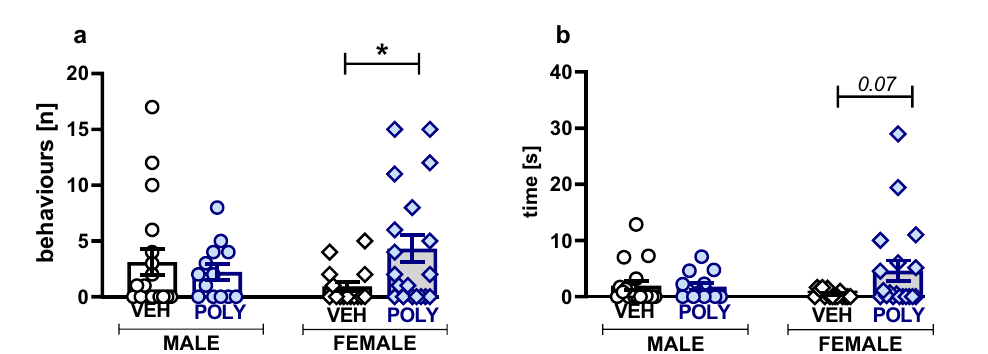
Figure 2. Aggressive behavior in the social interaction test. Poly(I:C) exposure increased the number and duration of aggressive episodes only in female rats. Data are presented as a mean ± SEM of the number of episodes ( a ) and time ( b ) of aggressive behavior. Symbols: *p < 0.05, a significant difference between vehicle- and poly(I:C)-exposed females (Mann–Whitney U